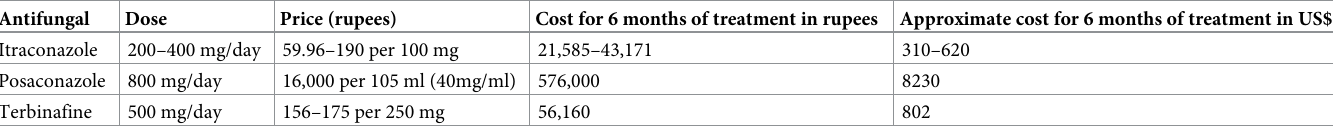
Table 1. Average cost of a six-month course of the commonly used antifungal agents in the treatment of eumycetoma. (The average annual income of a farm house hold in India is 77,112 rupees). Antifungal